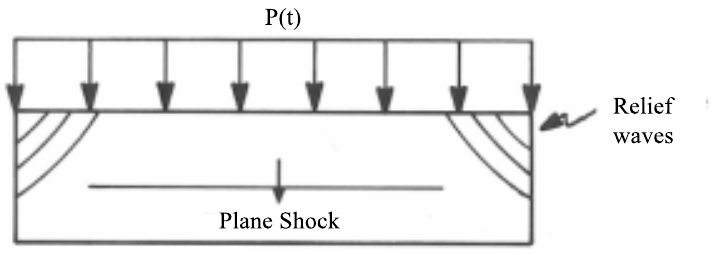
Fig. 1. Plane wave propagating through